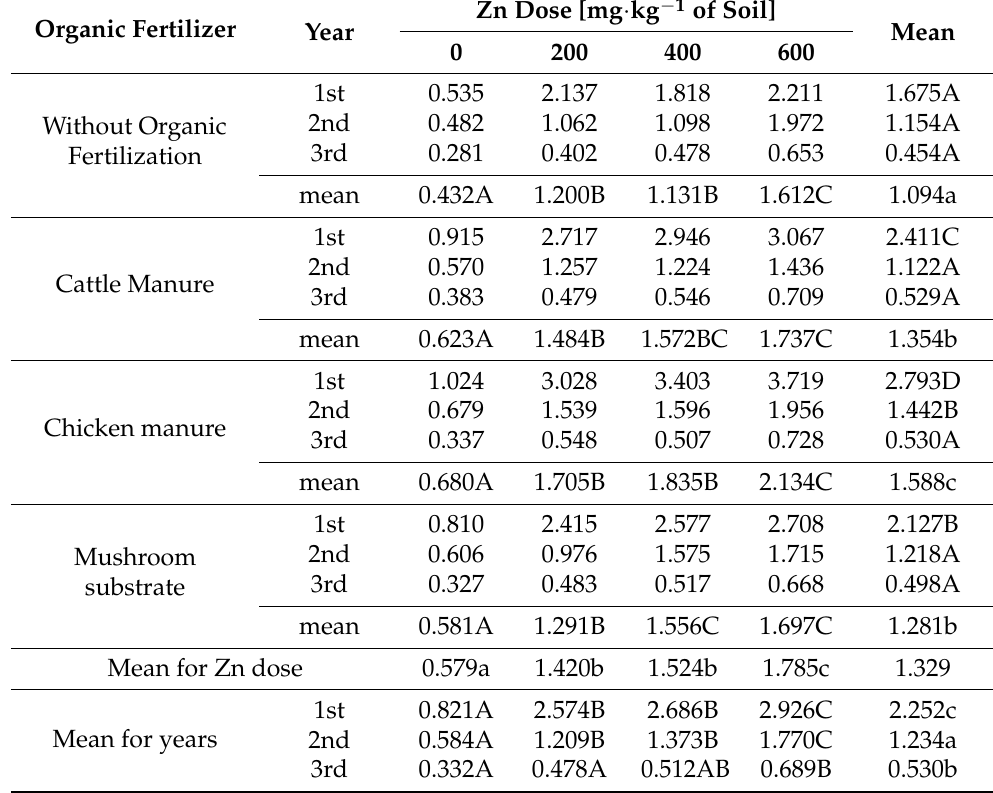
Table 6. Zn uptake by cocksfoot (mg Zn · pot − 1